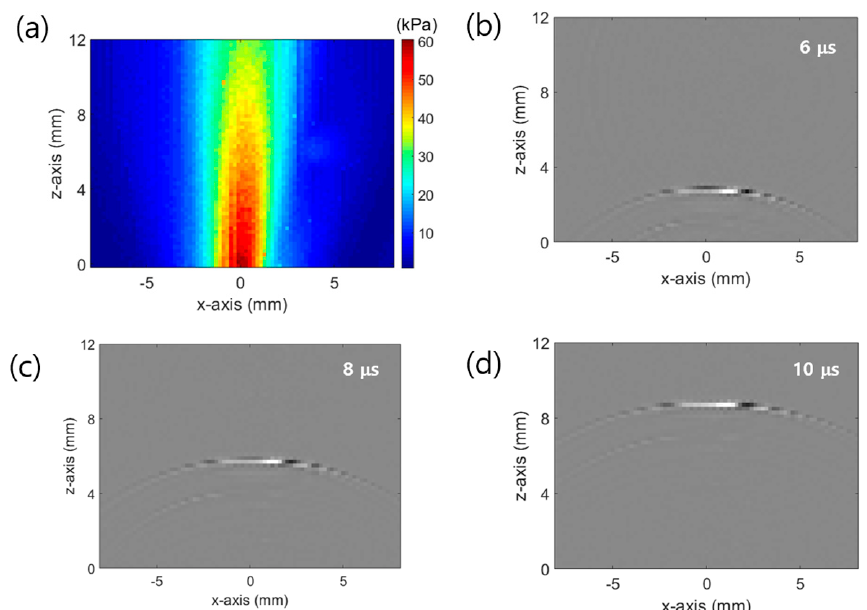
Figure 4. ( a ) Measured optical ultrasound pressure field generated by the CNTs in water medium; Sound wave propagation images at ( b ) 6, ( c ) 8, and ( d ) 10 µ s.